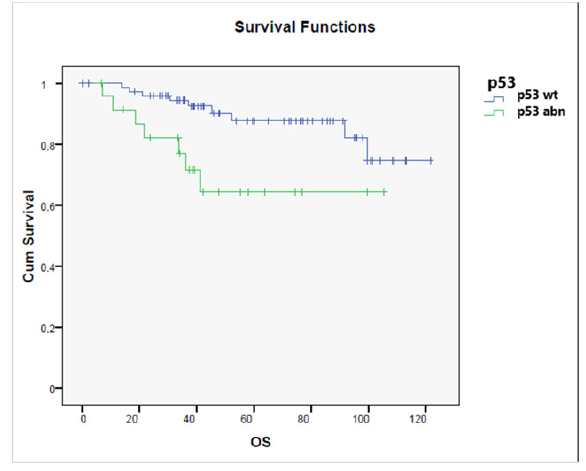
Figure 8. Overall survival according to the status of p53 status (p53 wild-type vs. p53 abnormal) ( p = 0.017).